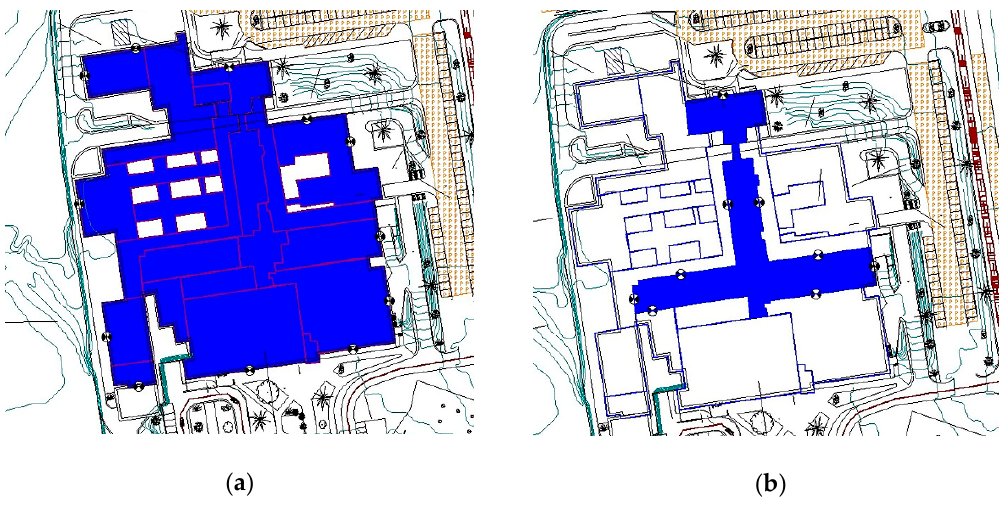
Figure 7. Horizontal sections of the building at different floors (marked in blue) together with the locations of some of the receiver evaluation points at the different facades. ( a ) The ground floor plan; and ( b ) the fourth to eighth floor plan.